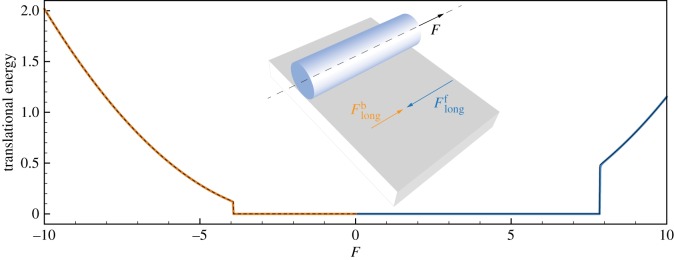
Anisotropic static and kinetic longitudinal friction. A rod initially at rest on a horizontal plane is pulled longitudinally with force F. The system is characterized by anisotropic friction so that resistance forces in the forward direction Fflong are larger than in the backward direction Fblong. The plot illustrates the behaviour of the total rod’s translational energy ET as a function of the force F applied. Blue and solid black lines correspond to, respectively, simulated and analytical ET for a rod pulled forward. Orange and dashed black lines correspond to, respectively, simulated and analytical ET for a rod pulled backward. Settings: length L=1 m, radius r= 0.025 m, mass m=1 kg, Young’s modulus E=105 Pa, shear modulus G=2E/3 Pa, shear/stretch matrix S=104×1 N, bend/twist matrix B=diag(EI1,EI2,GI3) Nm2, dissipation constant γ=10−6 kg (ms)−1, gravity g=9.81 m s−2, static and kinetic forward friction coefficients μfs=0.8 and μfk=0.4, static and kinetic backward friction coefficients μbs=0.4 and μbk=0.2, friction threshold velocity vϵ=10−4 m s−1, ground stiffness and viscous dissipation kw=10 kg s−2 and γw=10−4 kg s−1, discretization elements n=50, timestep δt=10−5 s, simulation time T=0.25 s.